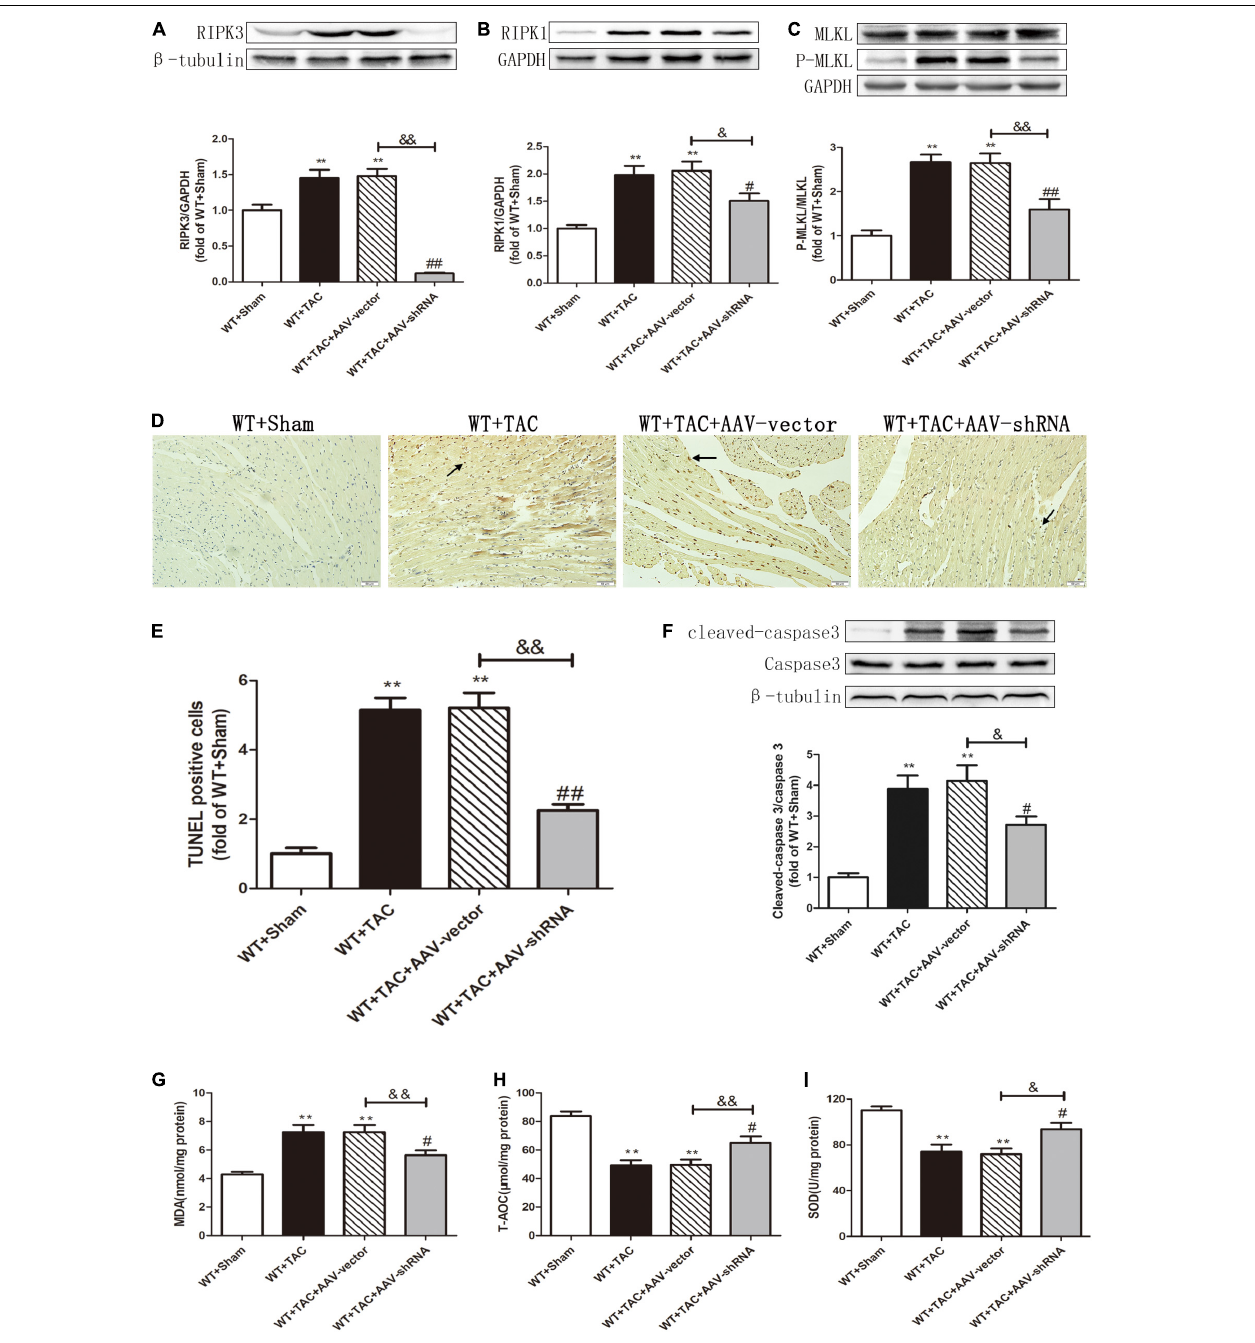
FIGURE 13 | Interference with RIPK3 can alleviate the up-regulation of RIPK3 and RIPK1, as well as the MLKL phosphorylation, reduce cardiomyocyte necroptosis, and improve antioxidant capacity in HF mice. Male 8-week-old WT mice were pretreated with AAV-vector and AAV-shRNA through the tail vein, and TAC was performed using a 28-g needle. The control group received sham surgery. All groups of mice were given continuous feeding for 6 weeks. Hearts were then obtained for correlative testing. (A) The expression of RIPK3 at the protein level in myocardial tissue was detected by Western blotting analysis, and β -tubulin was used as a loading control. (B) The expression of RIPK1 at the protein level in myocardial tissue was detected by Western blotting analysis, and GAPDH was used as a loading control. (C) The expressions of MLKL and P-MLKL at the protein level in myocardial tissue were detected by Western blotting analysis, and GAPDH was used as a loading control. (D) The level of apoptosis in myocardial tissue was measured by TUNEL staining, bar = 50 µ m. (E) The statistical chart of TUNEL-positive cells. (F) The expressions of cleaved caspase 3 and caspase 3 at the protein level in myocardial tissue were detected by Western blotting analysis, and β -tubulin was used as a loading control. (G) The levels of serum MDA, (H) T-AOC, (I) and SOD. Compared with WT + sham group, ** P < 0.01; compared with WT + TAC group, ## P < 0.01 and # P < 0.05; compared with WT + AAV-vector group, && P < 0.01 and & P < 0.05. n = 6.